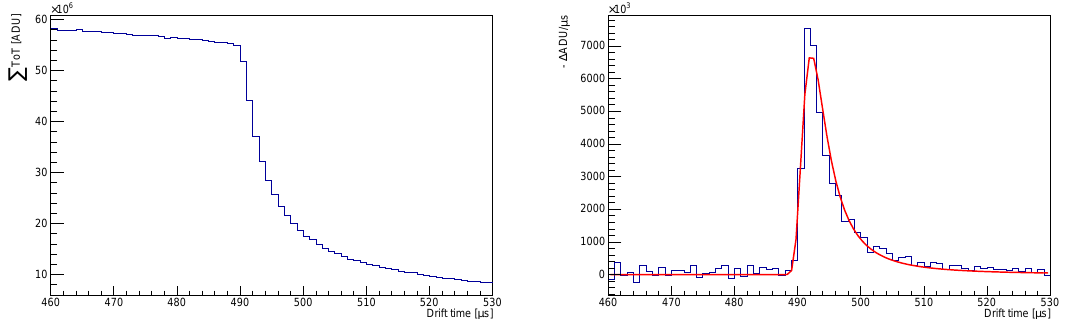
Figure 6. ( Left ) The summed ToT of hits as a function of the drift time t d , for a small range around the time approximately corresponding to the bottom of the TPC. A sharp drop is observed, indicating the cathode. ( Right ) The negative gradient of the summed ToT distribution. The steep drop now takes the form of a peak, to which a Landau function has been